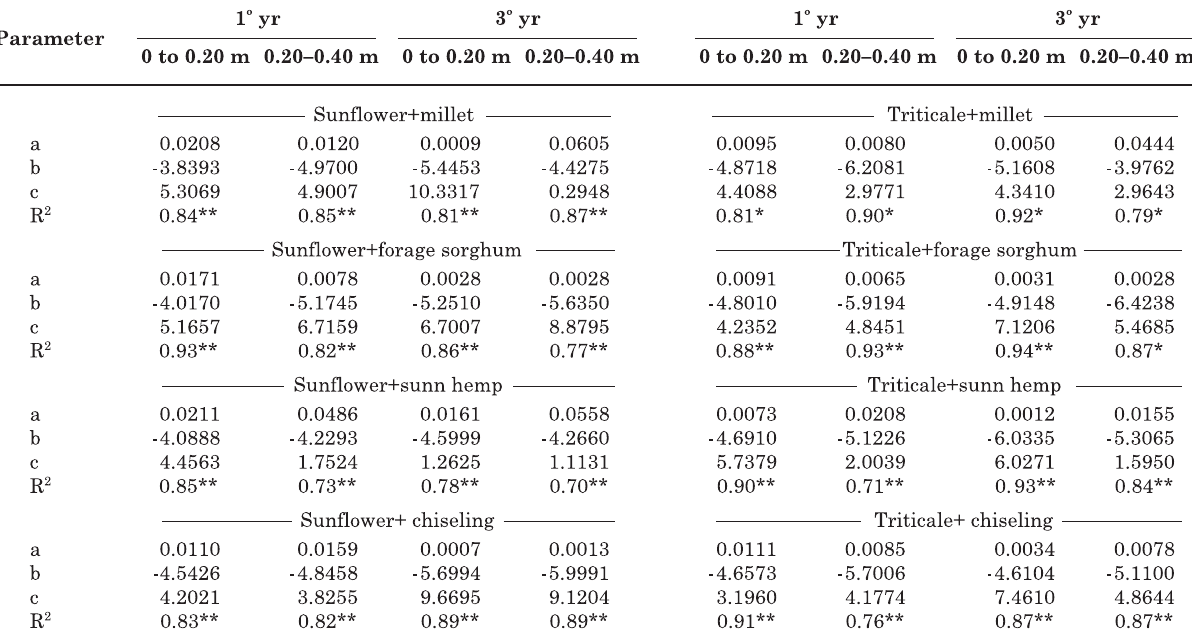
Significant at p <